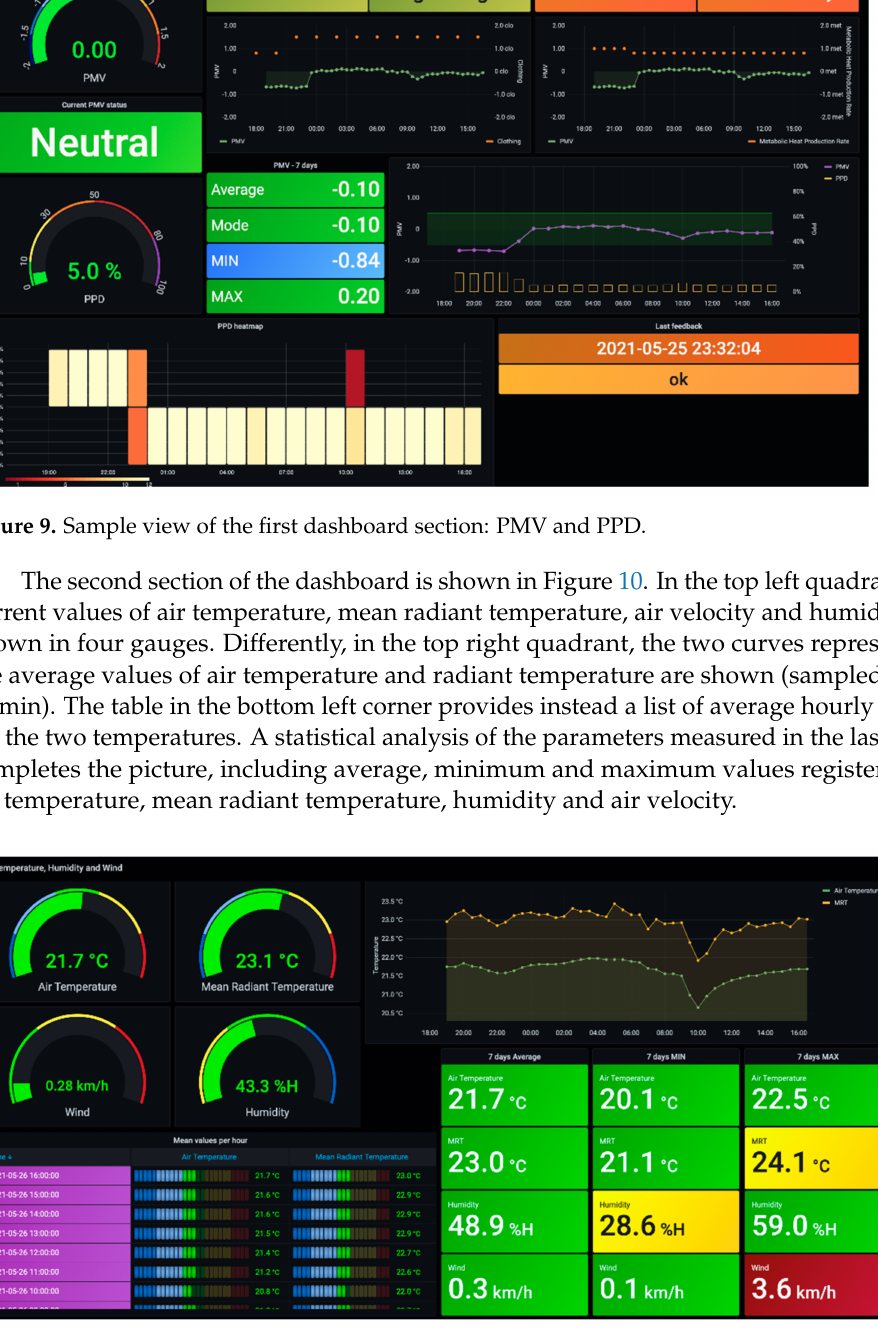
Figure 10. Sample view of the second dashboard section: temperature, humidity and